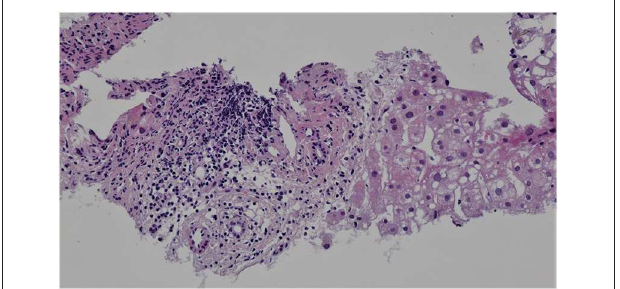
FIGURE 3 | Liver histology. Hematoxylin-eosin staining, magnification x200. Portal space inflammatory cellularization composed of lymphocytes and plasmocytes. Severe macrovesicular